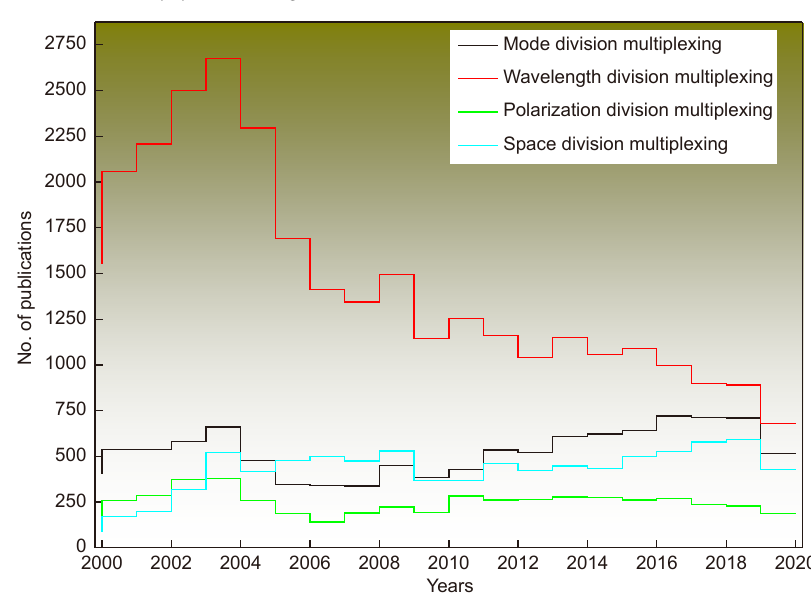
Fig. 1 | The number of research papers associated with different multiplexing techniques indexed in the Scopus